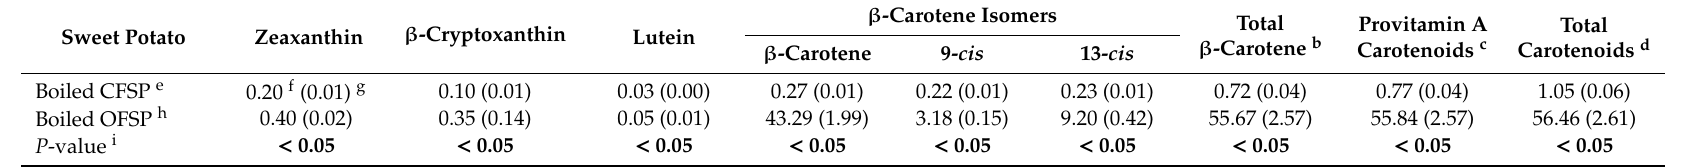
Table 10. Provitamin A content of provitamin A-biofortified sweet potato ( µ g / g, DW a